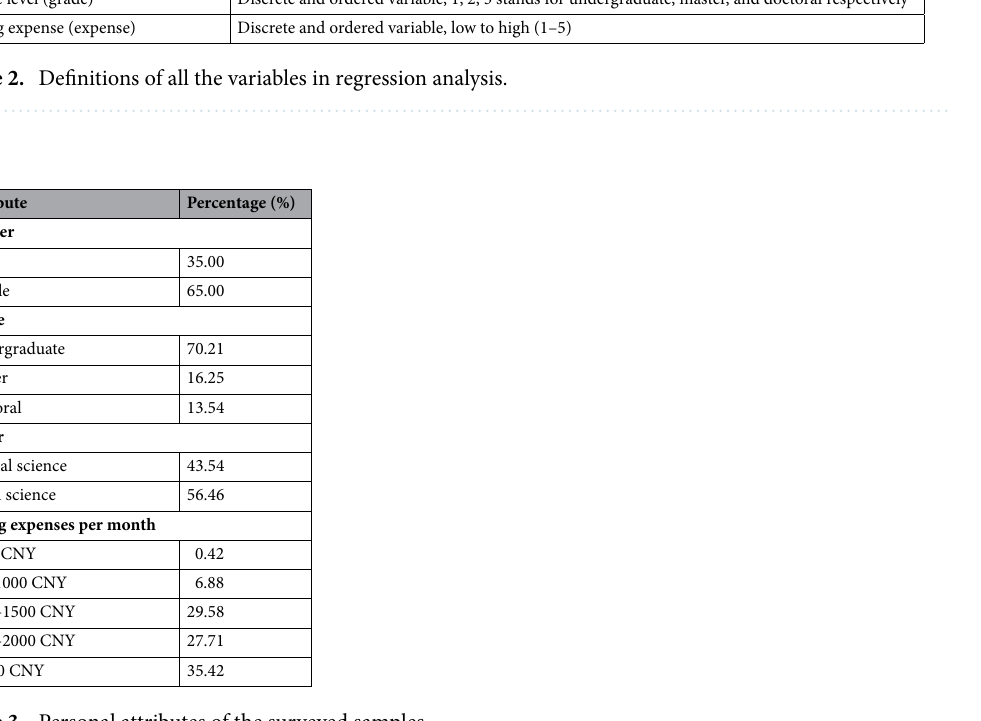
Table 3. Personal attributes of the surveyed